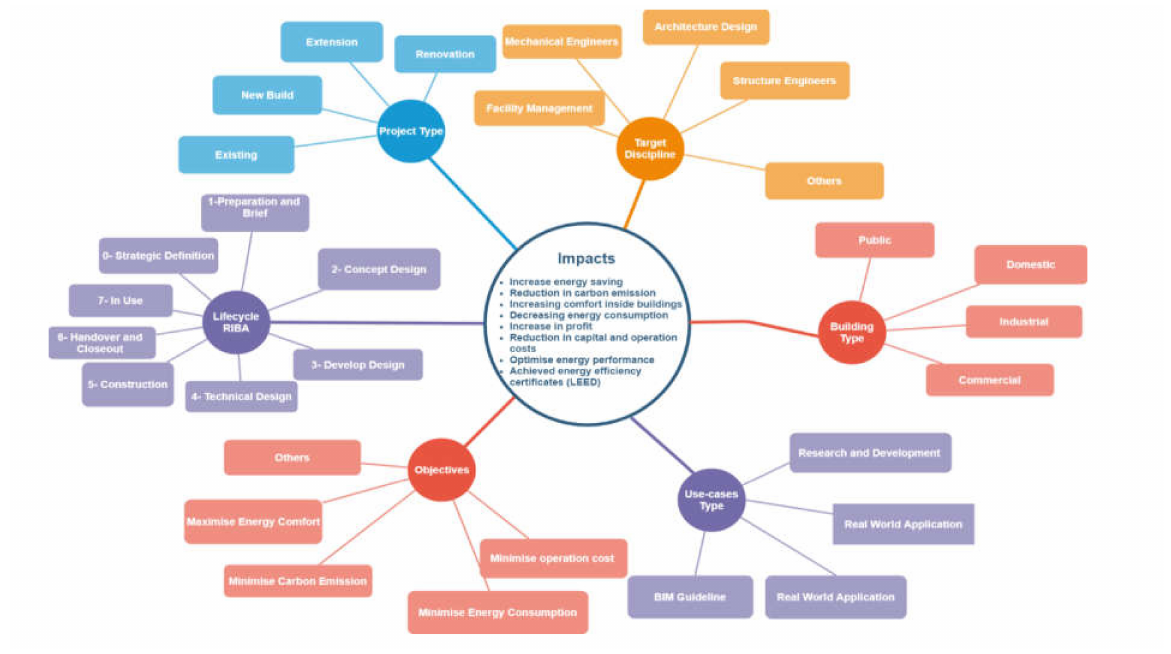
Figure 9. Ontology of use case concepts of BIM for